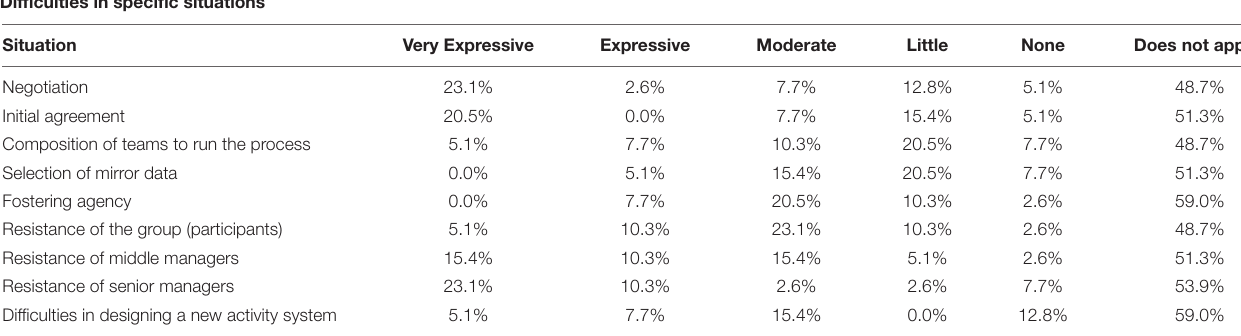
TABLE 1 | Difficulties encountered in specific change laboratory-related